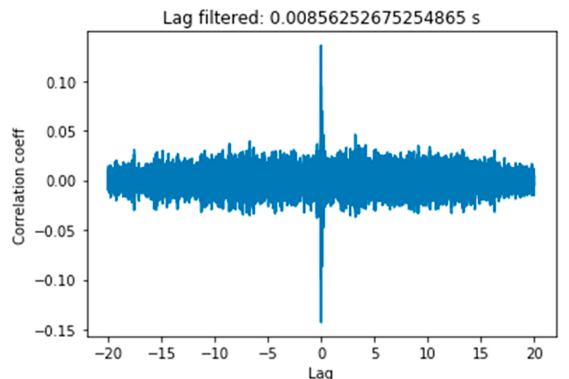
Figure 13. Positive / negative time lags to narrow leak Figure 13. Positive/negative time lags to narrow leak location.